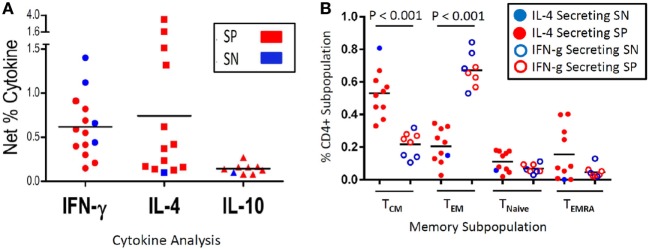
Malaria antigen-specific cytokine expression and corresponding memory subpopulation. Depicted is the net percentage of CD4+ T cell-derived IFN-γ, IL-4, or IL-10 cytokine secreted from peripheral blood mononuclear cells (PBMC) acquired from schistosoma-positive (SP) or -negative (SN) Malian children with evidence of antigen recognition after stimulation with malaria apical membrane antigen 1 antigen (A). Cells were gated on CD19−CD14−CD3+CD8−CD4+ after live/dead discrimination. Panel (B) depicts the memory subpopulation distribution from those PBMC that predominantly secreted IL-4 (a representative TH2 cytokine) (left column, solid dots, N = 9 SP, and 1 SN) or IFN-γ (a representative inflammatory TH1 cytokine) (right column, open dots, N = 4 SN and 4 SP) as depicted in Panel A (IL-10 not depicted). PBMC that expressed both cytokines (N = 7 SP and 0 SN) were categorized based on the dominant cytokine (defined as >50%) expressed. The memory subpopulations from one volunteer that secreted equal amounts of IL-4 and IFN-γ was excluded (B). Memory subpopulations were defined as T central memory (TCM—CD62L+CD45RA−), T effector memory (TEM—CD62L−CD45RA−), Naïve T cells (TNaive—CD62L+CD45RA+), or T effector memory RA+ (TEMRA—CD62L−CD45RA+). The mean value is represented as a horizontal bar and statistical significance set at P < 0.05.